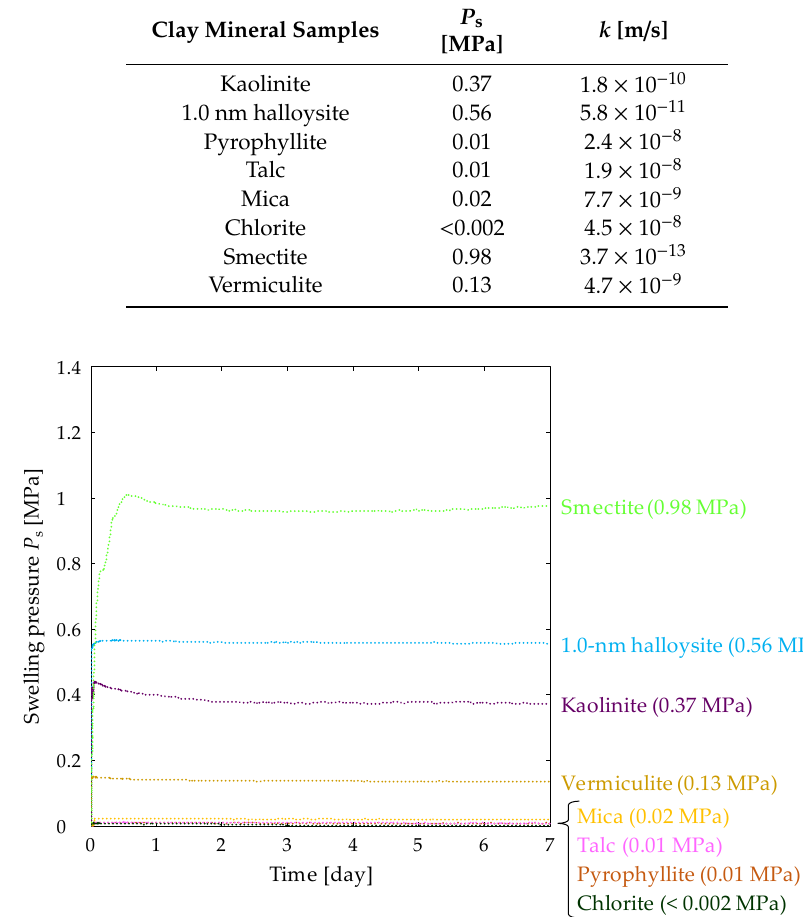
Figure 6. Swelling pressure of clay mineral samples (void ratio = 0.95).